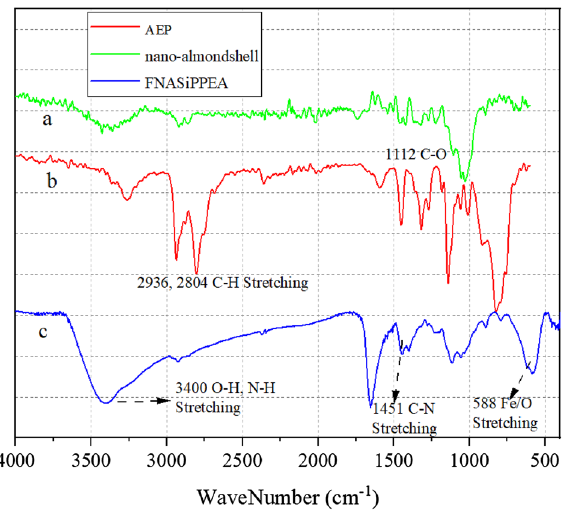
Figure 2. FT-IR spectra of ( a ) nano-almond shell, ( b ) AEP, and ( c )